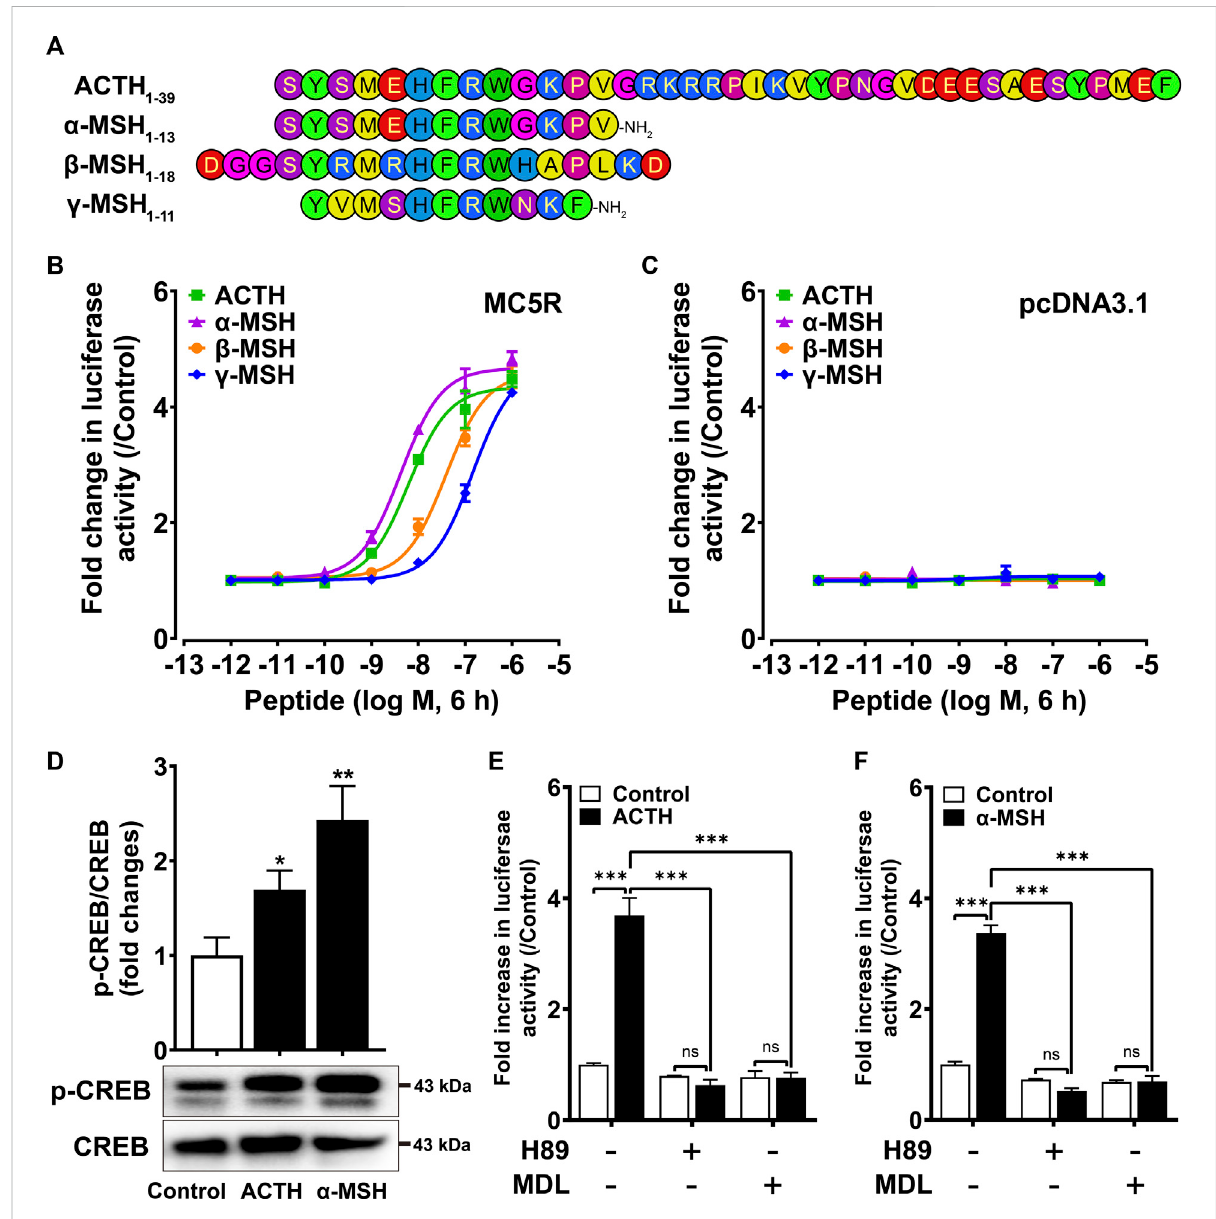
FIGURE 2 (A) Amino acid sequences of chicken ACTH, a-MSH (acetyl-a-MSH with an amidated C-terminus), β -MSH and γ -MSH (acetyl- γ -MSH with an amidated C-terminus) used in this study. (B) Effects of ACTH, a-MSH, β -MSH and γ -MSH in activating chicken MC5R expressed in Chinese hamster ovary (CHO) cells, as monitored by the pGL3-CRE-luciferase reporter system. Data are shown as the mean ± SEM of three replicates ( N = 3) and are representative of three independent experiments. (C) Effects of ACTH, a-MSH, β -MSH and γ -MSH in activating negative control pcDNA3.1 expressed in CHO cells. Data are shown as the mean ± SEM of three replicates ( N = 3) and are representative of three independent experiments. (D) Both ACTH and a-MSH treatment (10 nM, 10 min) could enhance CREB phosphorylation levels of CHO cells expressing cMC5R. The phosphorylated CREB (p-CREB) levels were quanti fi ed by densitometric analysis, normalized by that of cellular total CREB, and expressed as fold difference compared to the control (0 min). Data points represent the mean ± SEM of three independent experiments performed in triplicate. The representative set of Western blots is shown at the bottom. *, p < 0.05, **, p < 0.01 vs. control. (E – F) Effects of H89 (10 μ M) and MDL (5 μ M) on ACTH (10 nM, 6 h) (E) or a-MSH (10 nM, 6 h) (F) induced luciferase activities of CHO cells expressing cMC5R, monitored by pGL3-CRE-luciferase reporter system. H89 or MDL was added 0.5 h before treatment. Each fi gure shows one representative experiment repeated three times. ***, p < 0.001, ns, non-signi fi